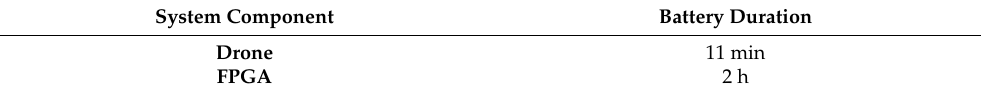
Table 3. Battery duration for drone and the